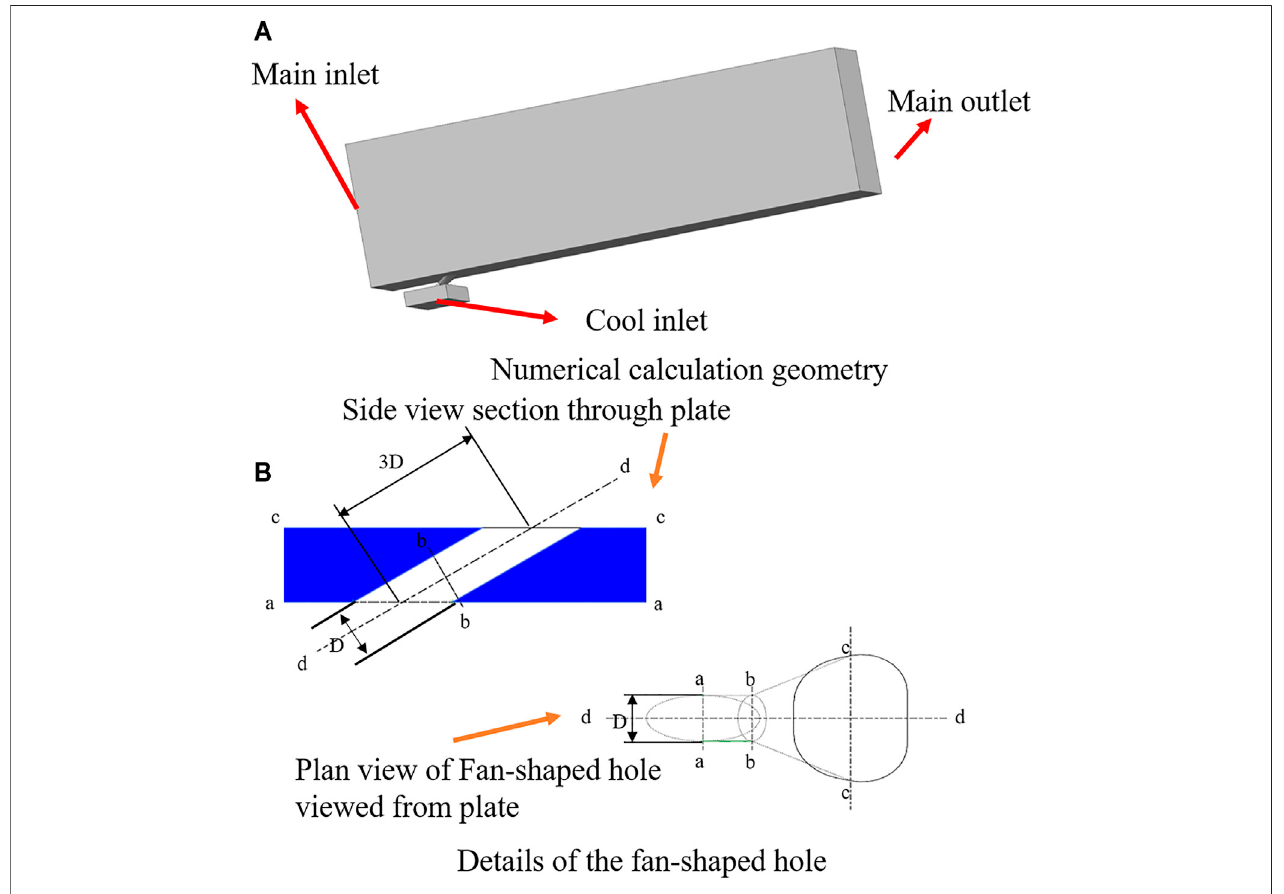
FIGURE 1 | Geometry. (A) Numerical calculation geometry and (B) details of the fan-shaped hole.